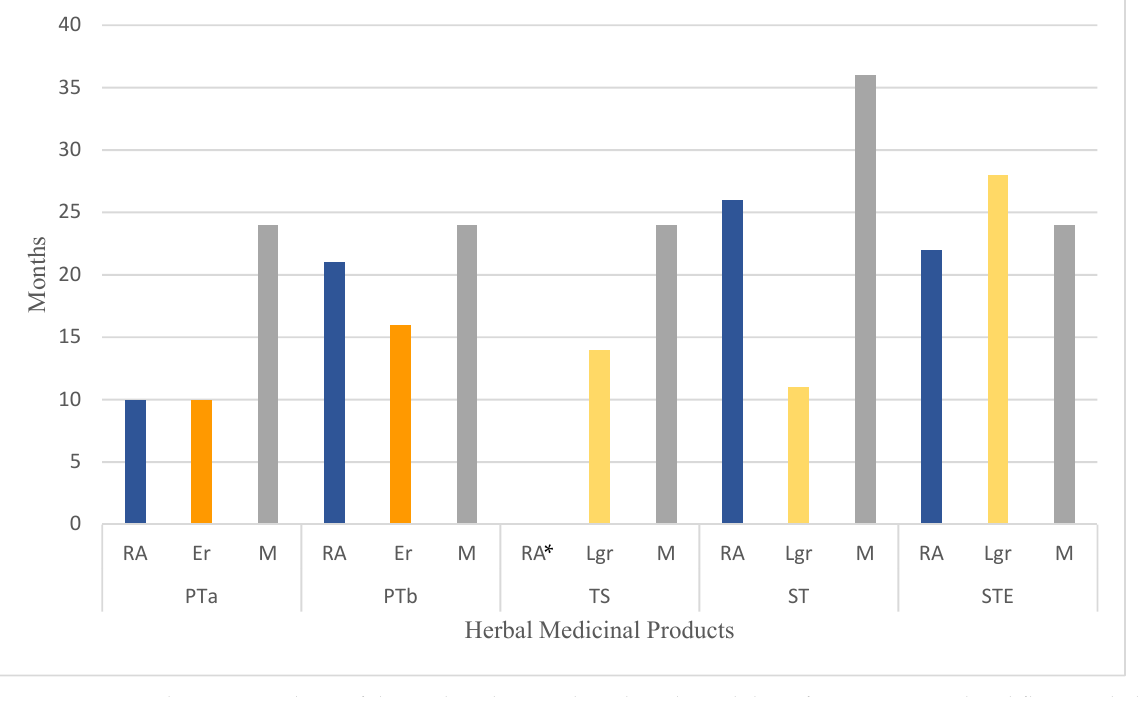
Figure 3. Determined expiration dates of the analyzed HMPs based on the stability of rosmarinic acid and flavonoid glycosides. RA — rosmarinic acid, Er — eriocitrin, Lgr—luteolin-7- O - β -glucuronide, M — manufacturer’s shelf-life; PTa, PTb — peppermint tinctures, batches a and b; TS — thyme syrup, ST — sage tincture, STE — sage and thyme liquid extract; RA* — stability of rosmarinic acid for thyme syrup could not be estimated.